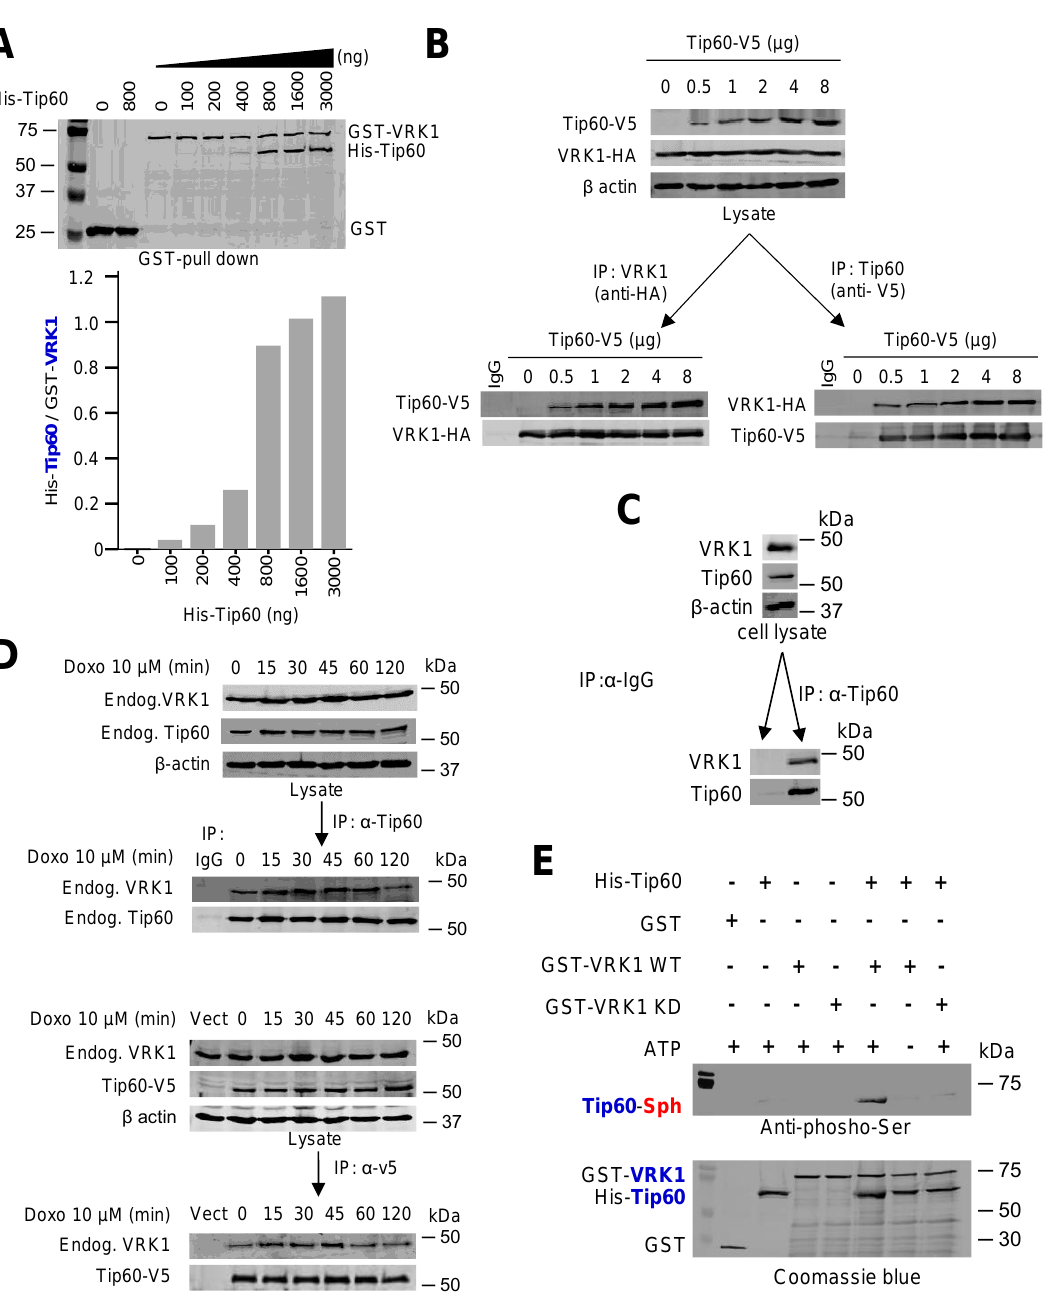
Figure 3. VRK1 direct interaction and phosphorylation of Tip60. ( A ). Binding of Tip60 to human VRK1. Increasing amounts of His-Tip60 were incubated with a fixed amount (1000 ng) of GST-VRK1, followed by a pulldown of GST-VRK1 and determination of Tip60. In the gel was included an assay with GST to rule out a non-specific interaction with His-Tip60. Proteins were detected by immunoblot with specific monoclonal antibodies for the GST and His epitopes. ( B ). Direct interaction between VRK1 and Tip60. Cells were transfected with tagged plasmids expressing human VRK1-HA and Tip60-V5. The complex between these two proteins within cells was detected by reciprocal immunoprecipitations. ( C ). Immunoprecipitation of endogenous Tip60 with an anti-Tip60 antibody (ab137518) and detection of endogenous VRK1 in the immunoprecipitate. ( D ). Doxorubicin treatment does not alter the interaction between endogenous VRK1 and Tip60 (top) or between endogenous VRK1 and transfected Tip60-V5 (bottom). E. Direct in vitro phosphorylation of Tip60 by VRK1 using bacterially expressed and purified proteins. Phosphorylated Tip60 was determined with an anti- phosphoserine antibody.